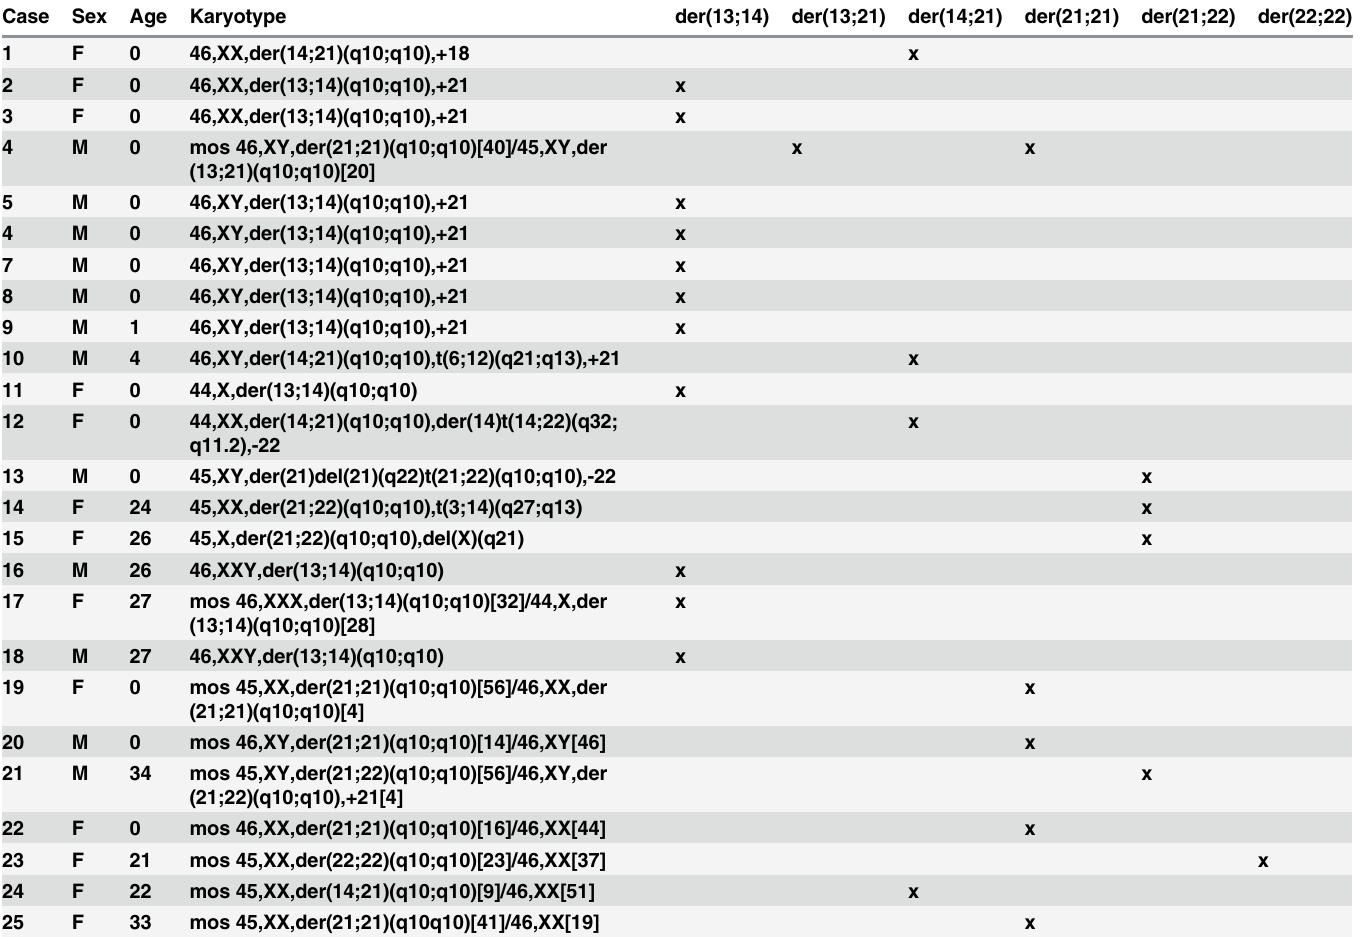
clearly documented. Given the facts that more than 94% of Chinese in mainland China are Table 3. Total cases of mosaic/complex Robertsonian translocations (ROBs) detected in this study. Case Sex Age Karyotype